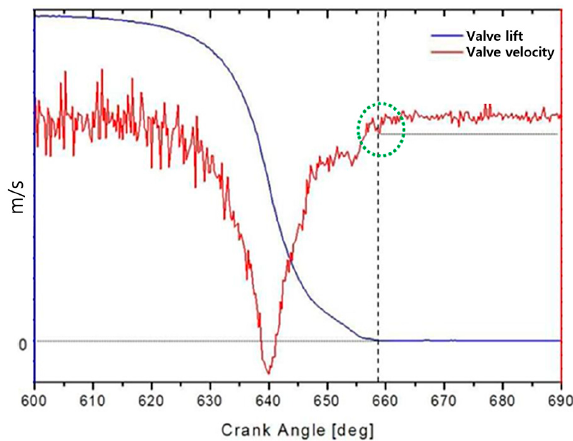
Figure 3. Crank angles for valve lift and valve speed.